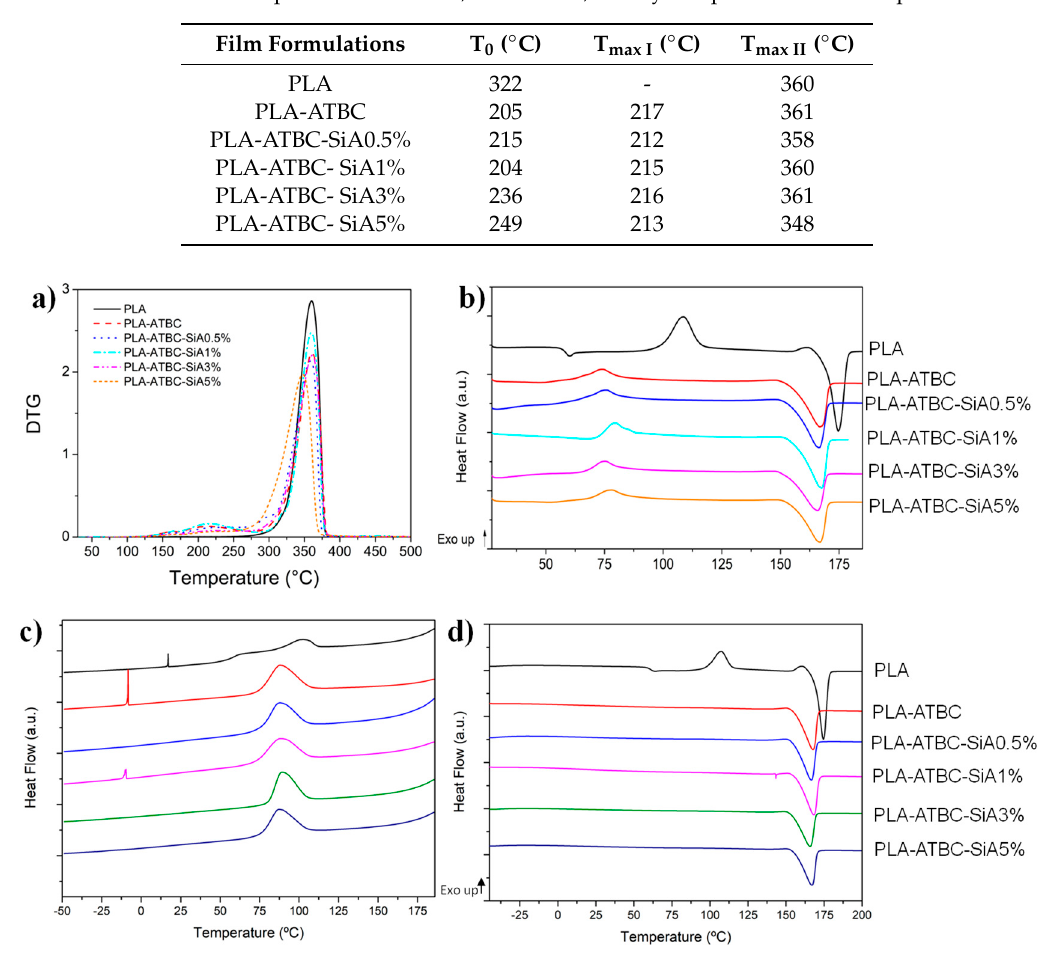
Table 2. TGA and DTG parameters of PLA, PLA-ATBC, and hybrid plasticized biocomposite films.